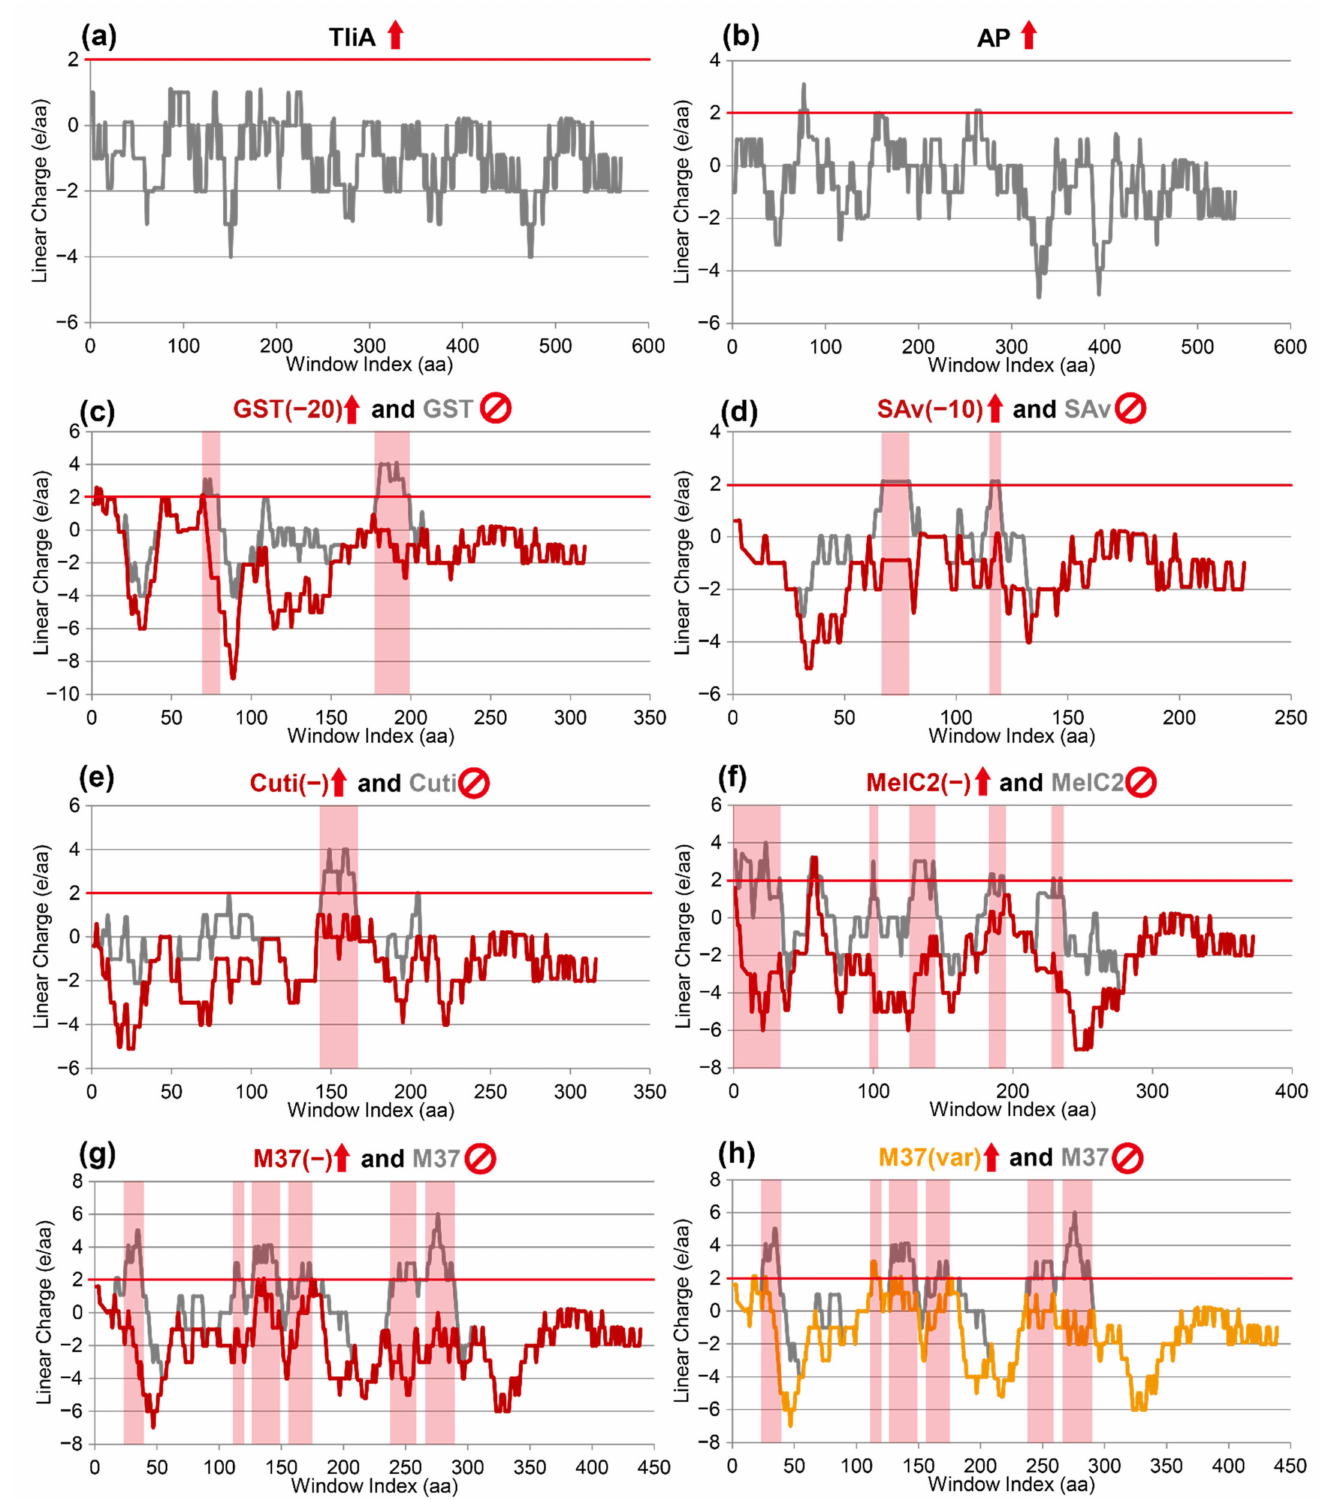
Figure A3. The linear charge density graphs omitted from the main text. The horizontal red lines indicate the arbitrary +2 e /aa threshold which we set. The prominent peaks are marked with the red background color. A red arrow indicates that the protein was secreted, while a red cancellation sign indicates that the protein was not secreted. ( a ) The LCD graph of TliA, the natural substrate of the TliDEF ABC transporter that we used in this experiment. ( b ) The LCD graph of a typical secretable protein, E. coli alkaline phosphatase (AP). Note that the peaks above +2 are not prominent. ( c , d )